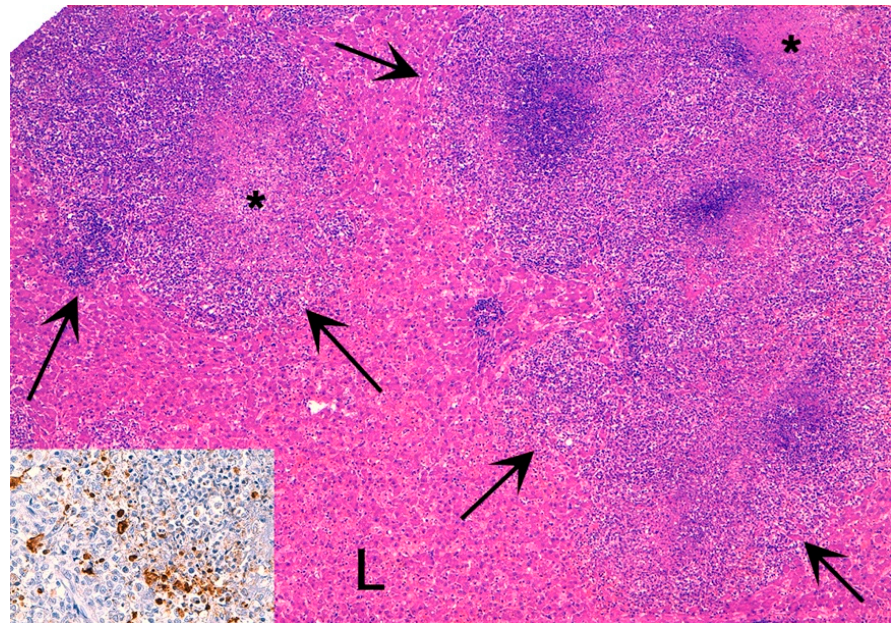
Figure 1. Feline infection peritonitis (FIP), liver (L), cat. Hepatic parenchyma is effaced by a multifocal to coalescent mixed inflammatory infiltrate (arrows) with central necrosis (asterisks). Hematoxylin eosin stain. Inset: Immunohistochemistry shows intense brown cytoplasmic immunolabelling for feline CoV antigen within macrophages.